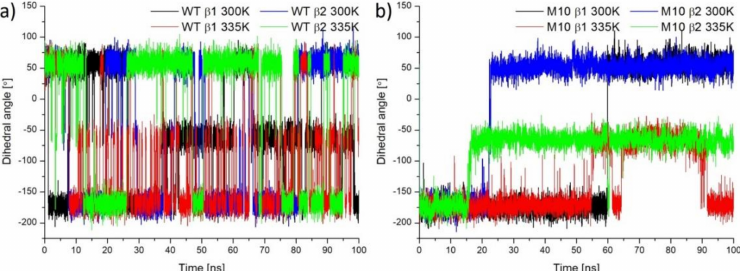
Figure 14. χ 1 dihedral angle of β Ser130 ( a ) in case of simulation for WT NHase and β Tyr130 ( b ) in case of simulation for M10